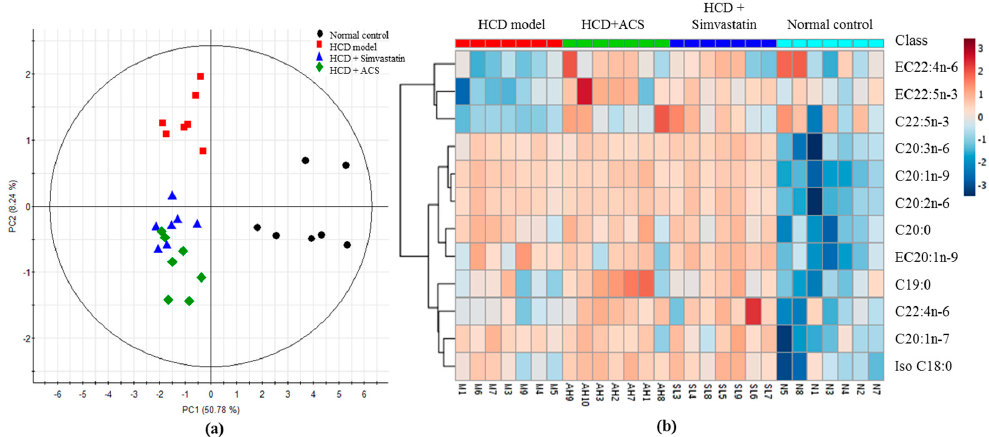
Figure 6. GC-MS results of FFAs and EFAs of rat serum: ( a ) the partial least squares discriminant analysis (PLS-DA) score plot of FFAs and EFAs level data sets (after automatic transformation). R 2 Y (cum) = 0.57, Q 2 (cum) 0.50; and ( b ) A heatmap of FFAs and EFAs of GC-MS contributing to the classification of PLS-DA [Variable Importance in the Projection (VIP) value ≥ 1].